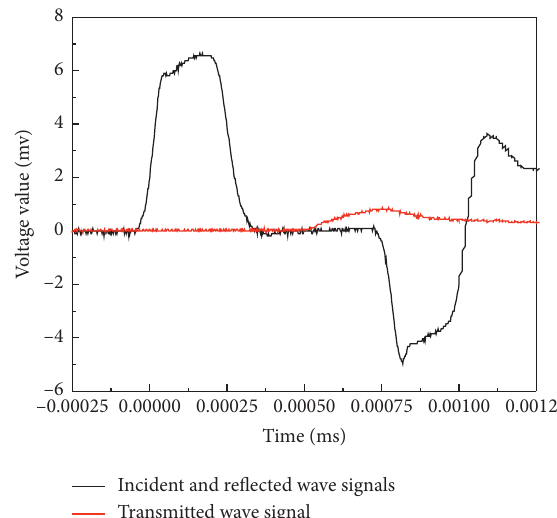
Figure 8: Waveform with no gap between incident and absorption bars.